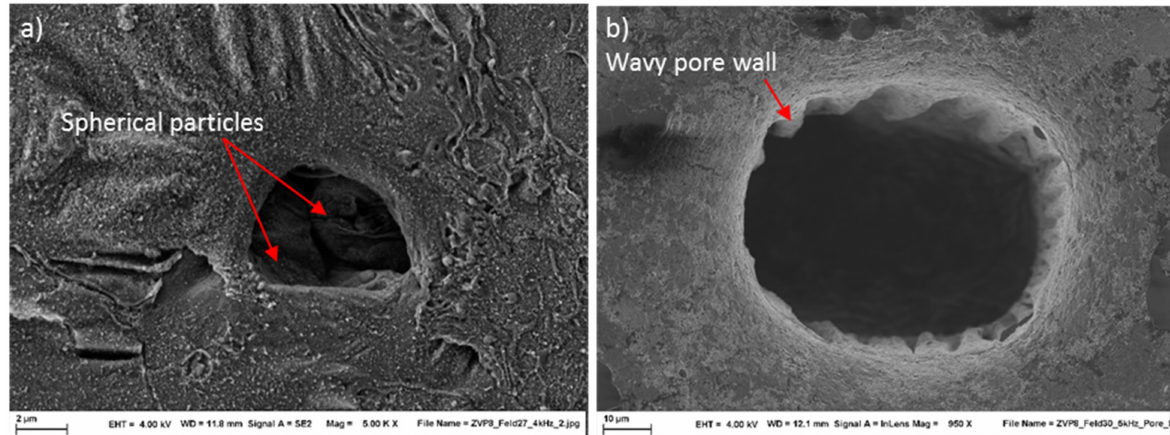
Figure 19. Surface open pores, ( a ) powder particles at the bottom, ( b ) deep pore with a wavy wall.